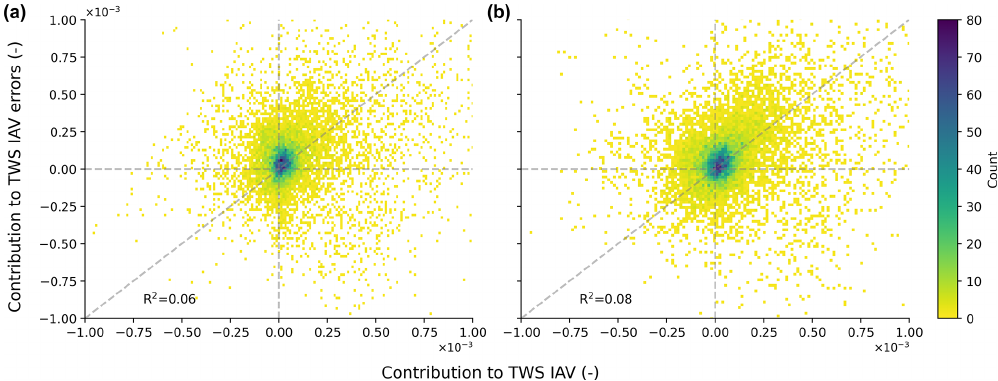
Figure B8. Bivariate histograms that compare the pixel-wise contribution to the global terrestrial water storage (TWS) interannual variabil- ity (IAV) versus pixel-wise contributions to the global TWS IAV modeling error in SINDBAD (a) and H2M (b) . The pixel-wise contribution is quantified using Eq. (4) (see Sect. 2.1.2). Colors mean the number of cases with corresponding ranges of contribution to TWS IAV and contribution to TWS IAV errors. R 2 at the bottom left is calculated as the square of the Pearson correlation